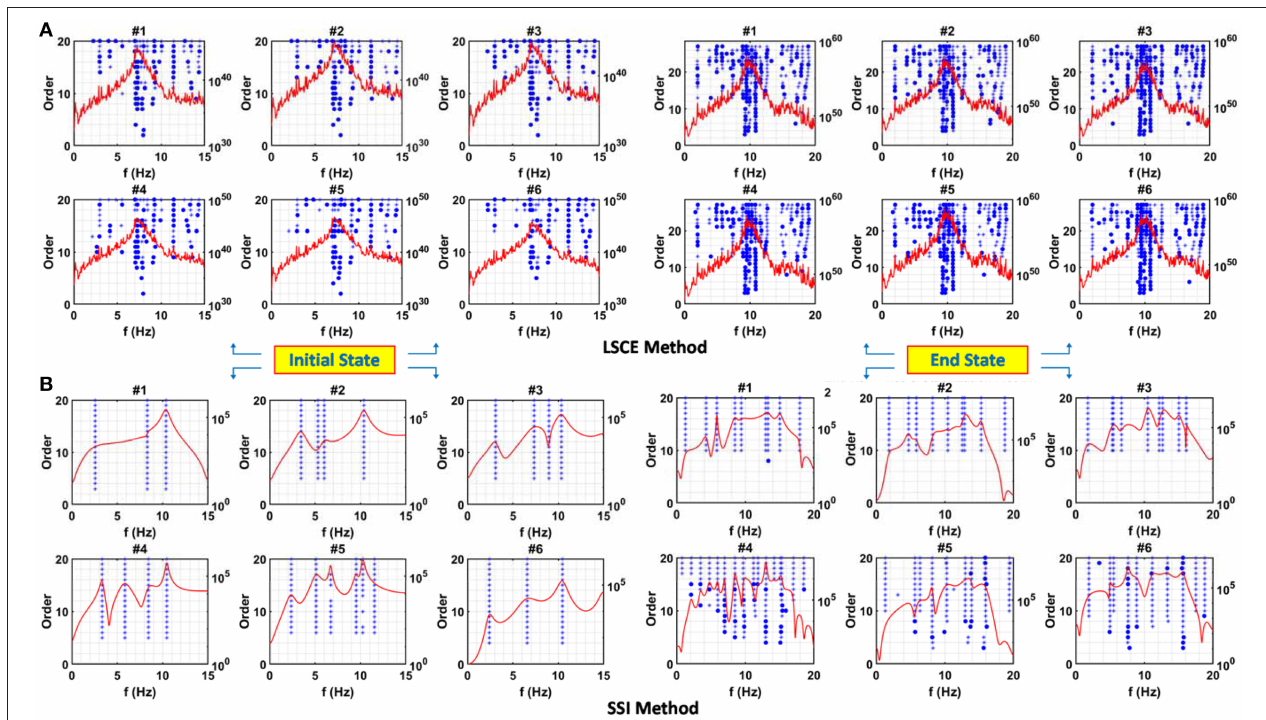
FIGURE 8 | Frequency response and stabilization diagram of the steel girder bridge (Bridge #2) using (A) LSCE methods and (B) SSI methods before and after the seismic tests (initial and end states). The criteria are 1% for frequencies and 5% for damping ratios, symbols in stabilization diagram “*”indicates stable frequency and damping; “o” is stable